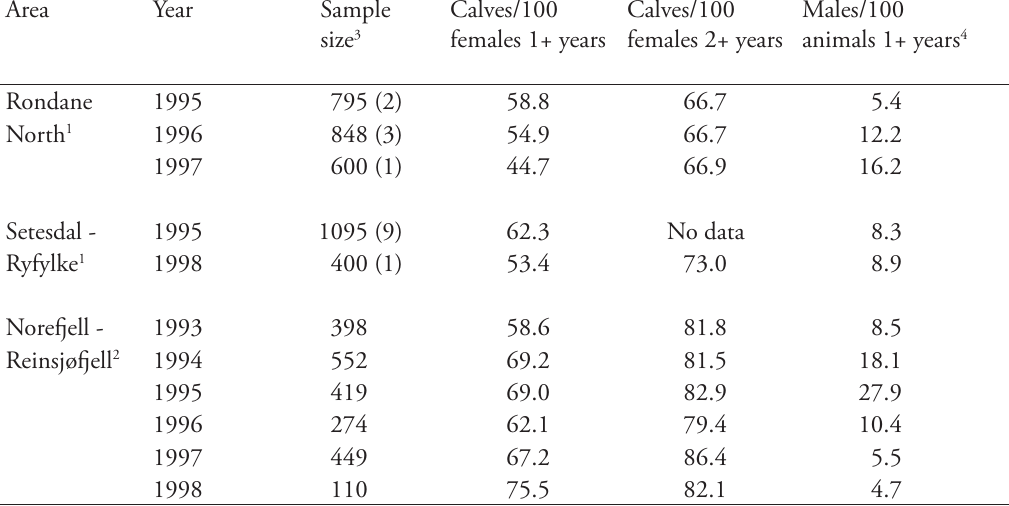
Table 1 . Group composition in wild reindeer herds in southern Norway estimated from ground counts in June-July . Number of reindeer groups in parenthesis . Different groups are pooled and figures rep- resent percentages in total sample within area and year . Number of groups is in